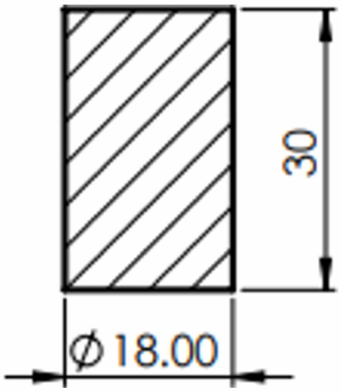
Figure 9. Dimensions of the cylindrical